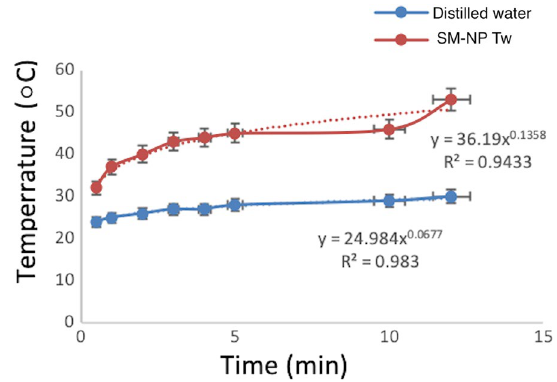
Fig. 7 Photothermal responses of SM-NP-Tw and distilled water upon light